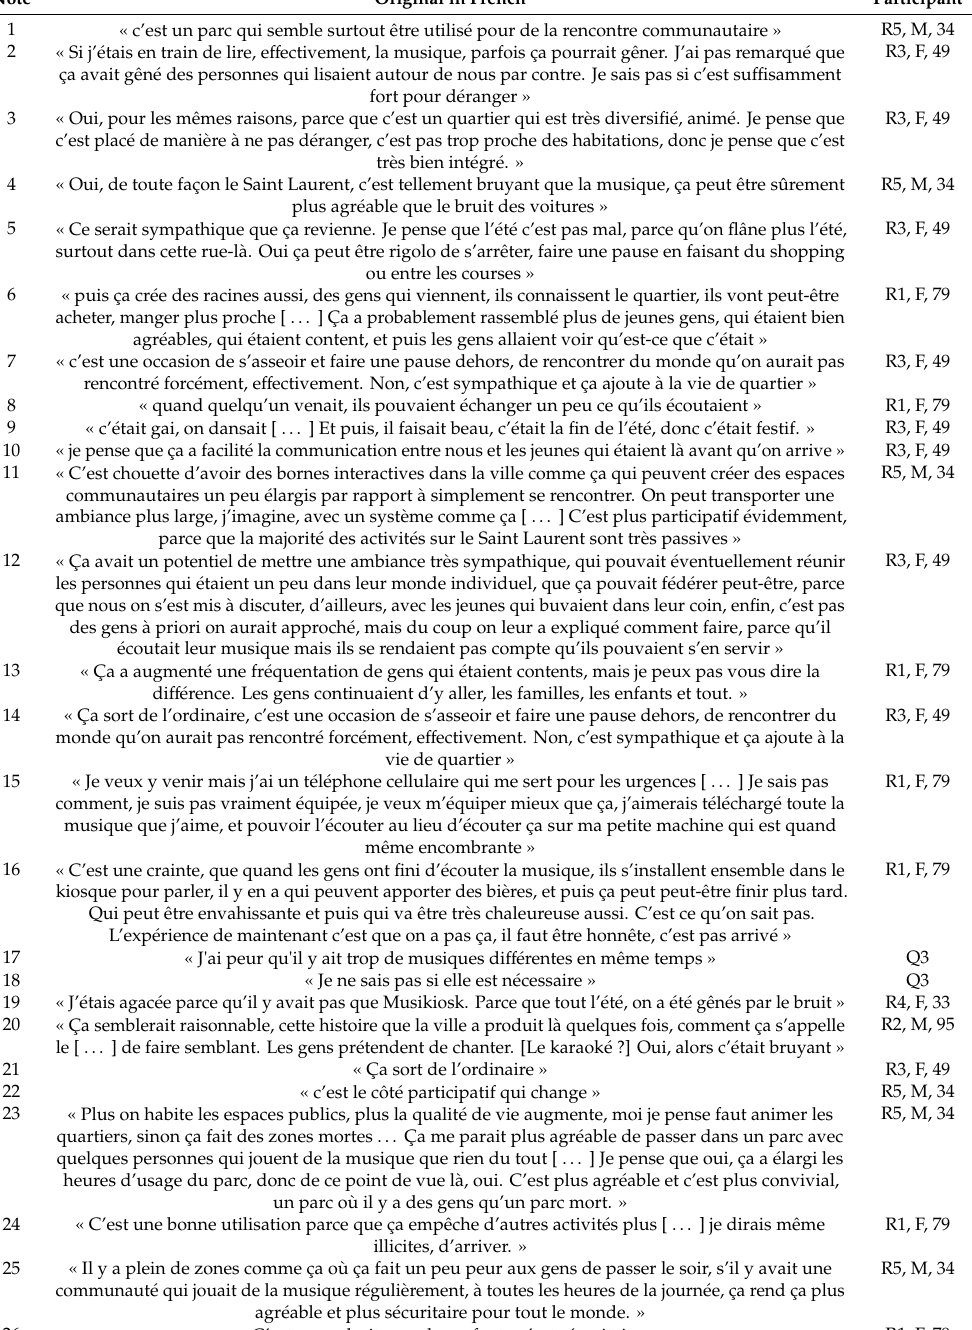
Table A6. French